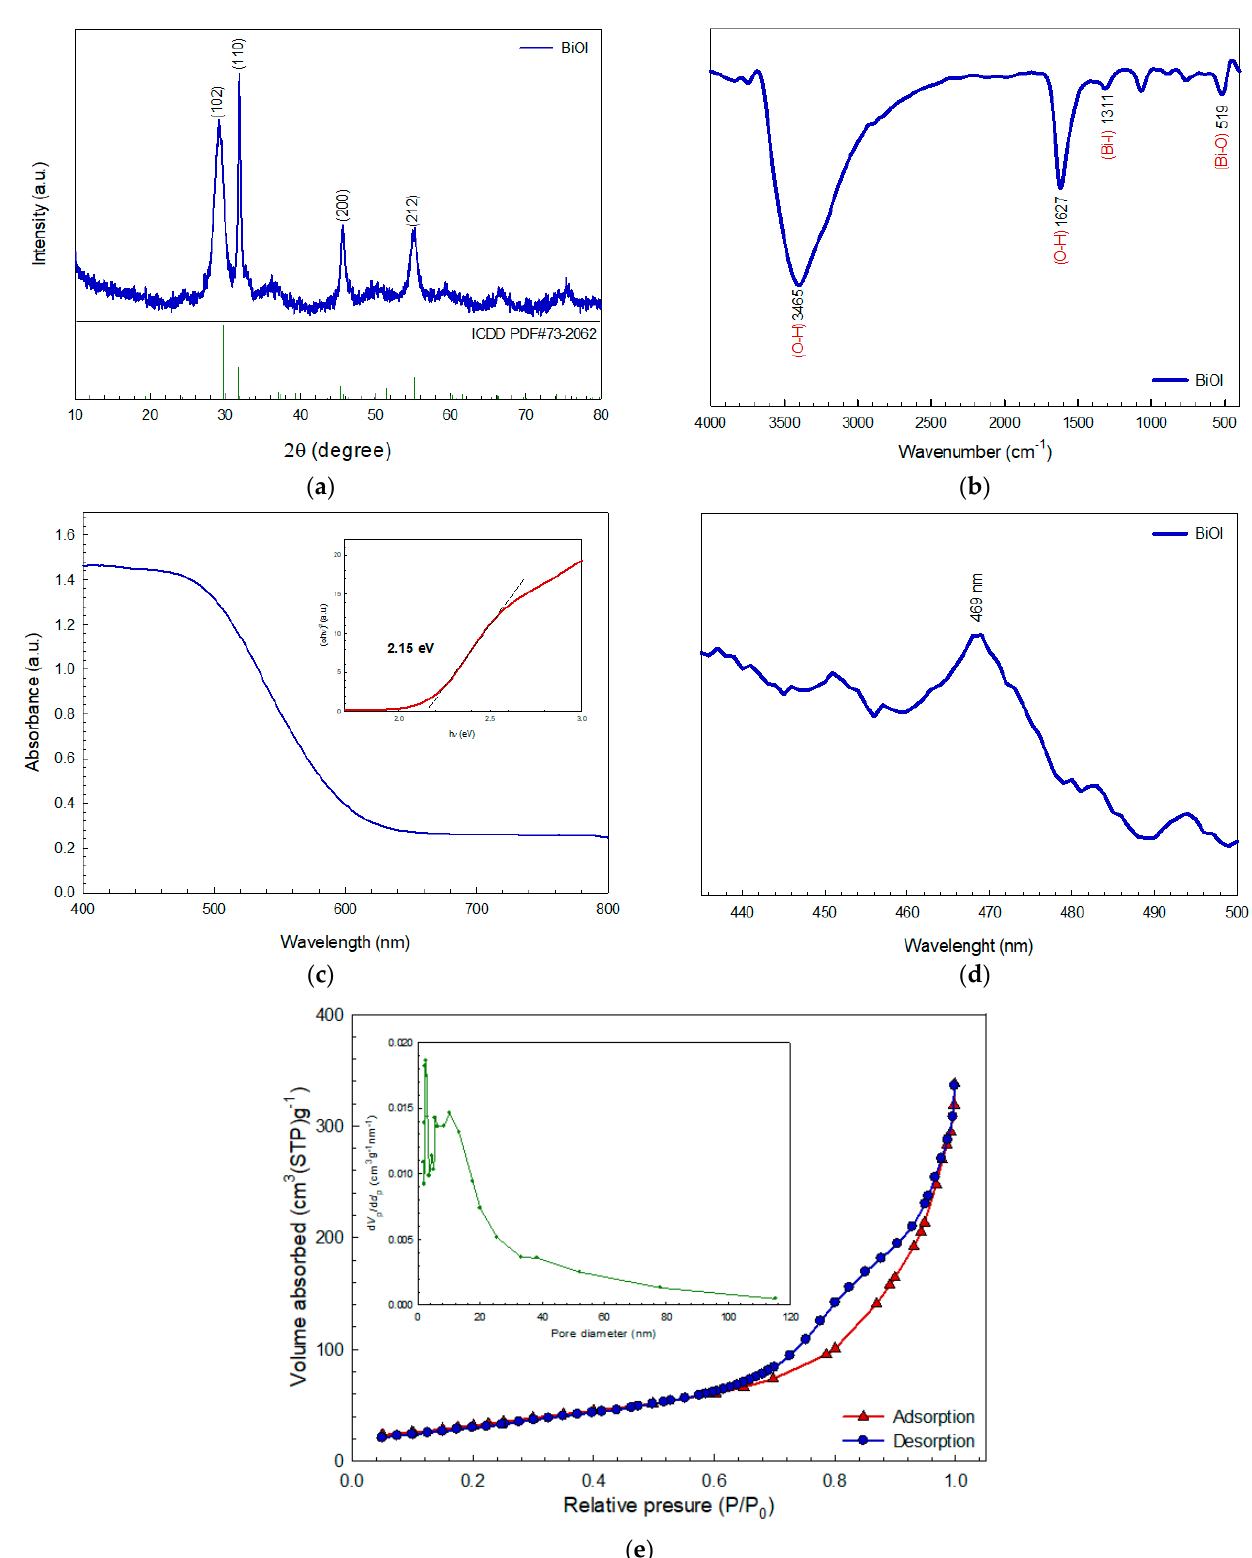
Figure 1. XRD pattern ( a ), FT-IR spectrum ( b ), UV-vis spectrum ( c ), PL spectrum ( d ), and nitrogen adsorption-desorption isotherm and BJH pore size distribution of the BiOI photocatalyst ( e ).